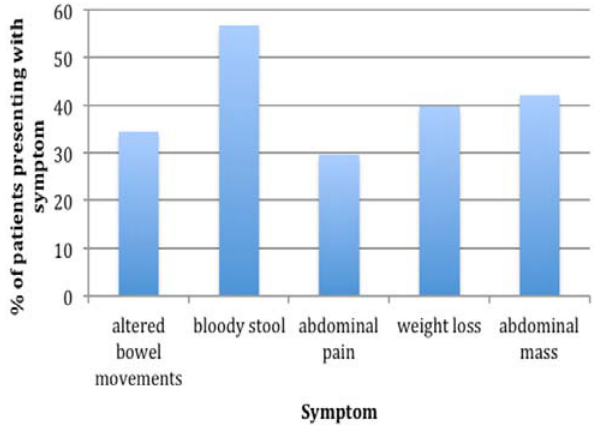
Figure 11 Presenting symptoms in colorectal cancer.